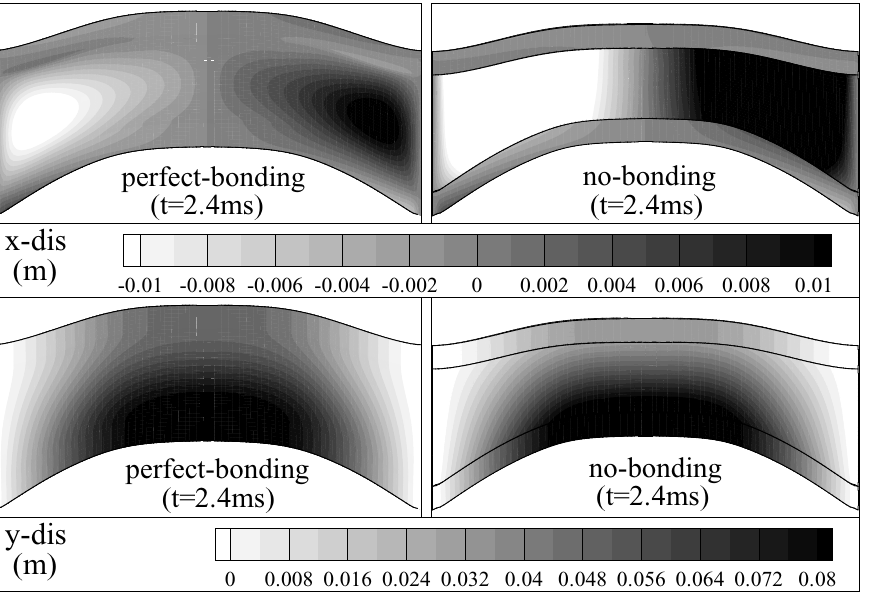
Fig. 17. Comparison of the horizontal (x-direction) and vertical (y-direction) displacement fields at t = 2 . 4 ms between the perfect- and no-bonding sandwich plates with clamped